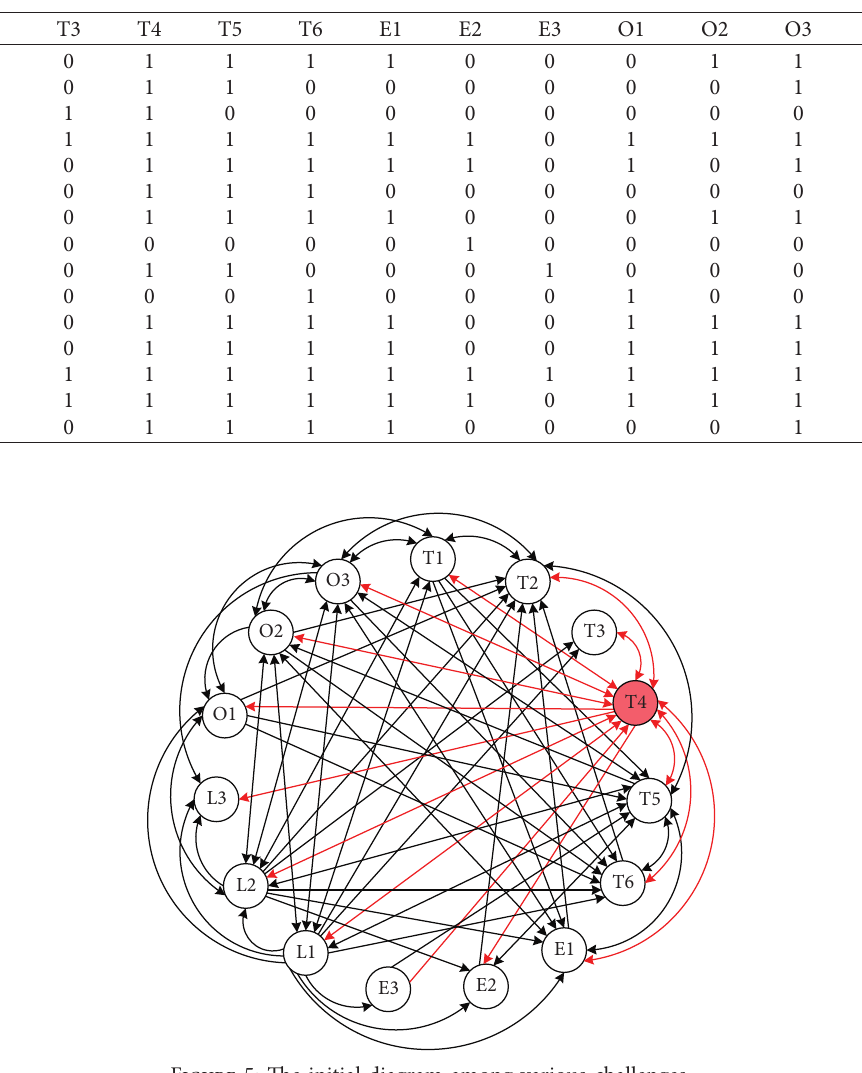
Table 12: Reachability matrix K .